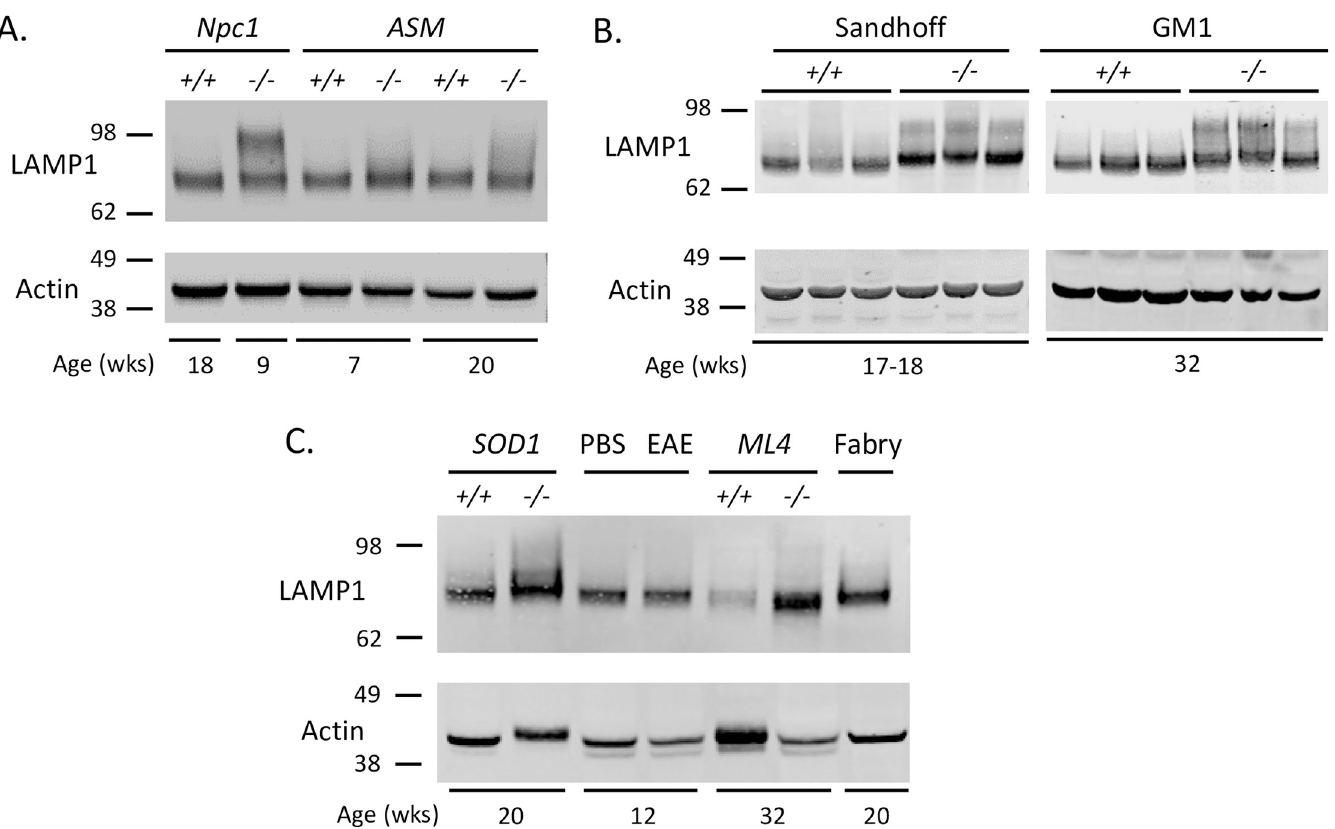
Fig 7. Hyperglycosylated LAMP1 is unique to NPC diseases. A. LAMP1 Western blot of whole cerebellar lysate from 18-week Npc1 +/+ , 9-week Npc1 −/− and 7- and 20-week-old acid sphingomyelinase KO mice (Niemann Pick Type A/B). B. LAMP1 Western blot of whole cerebellar lysate from control (+/+) and affected (-/-) ~18-week-old Hexb (Sandhoff) and 32-week-old Glb1 (GM1) mice. C. LAMP1 Western blot of tissue lysate from control and mutant 20-week-old SOD1 mice (spinal cord), 12-week-old EAE mice and PBS control (cerebellum) and 32-week-old ML4 mice (hippocampus). Mouse cerebellar lysate from a 16-week-old Fabry mouse was used as a neuro-inflammation negative